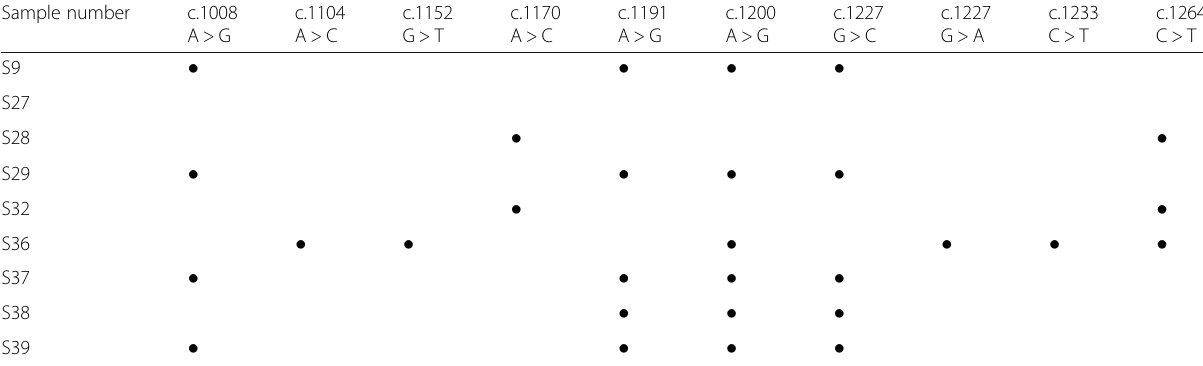
Table 3 Nucleotide changes identified in HPV83-L1 when compared to the reference sequence (AF151983) in nine HPV83+ samples